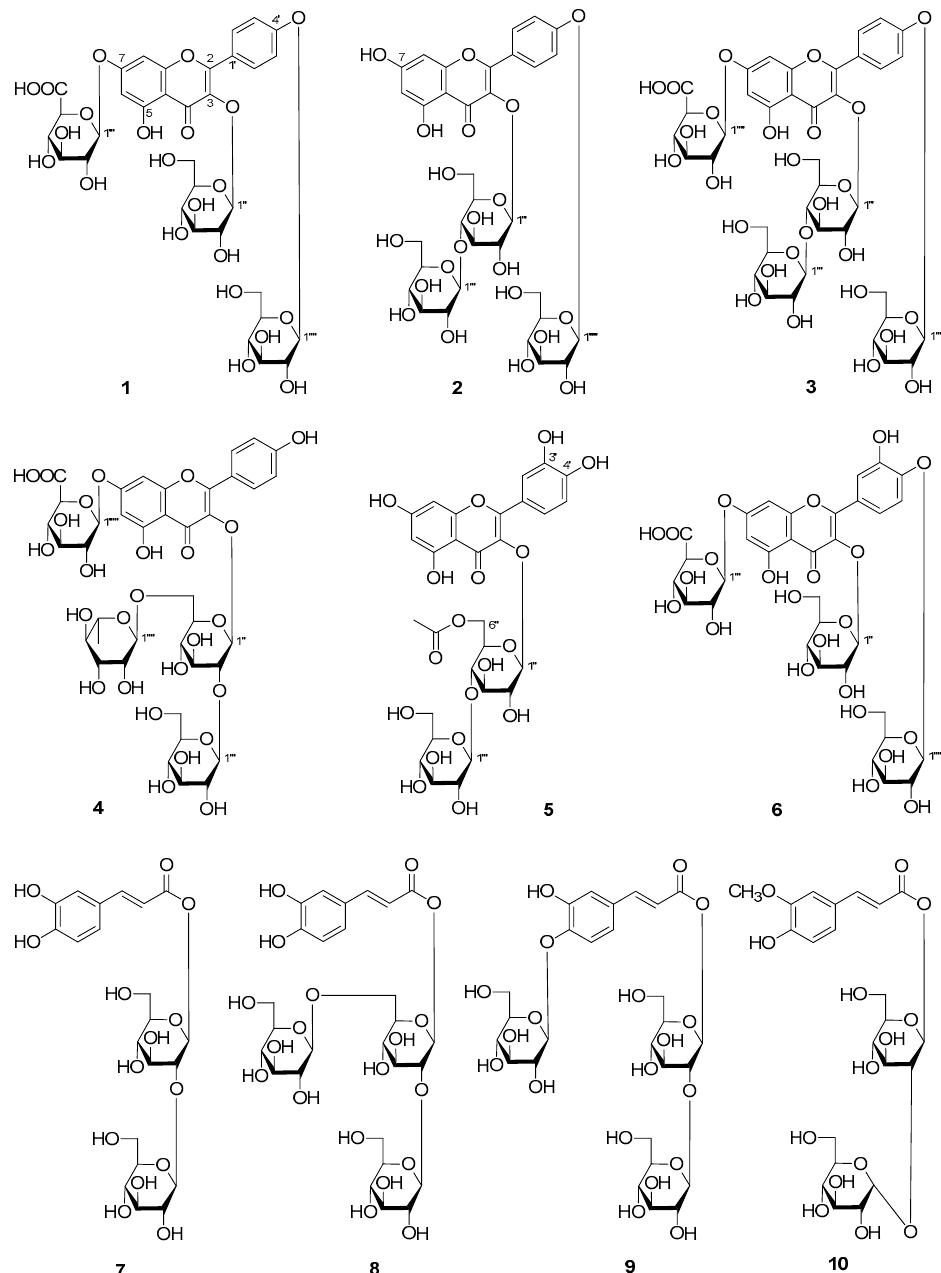
Figure 1. The new compounds obtained from the aerial parts of A. mongolicum ( 1 − 10 ).